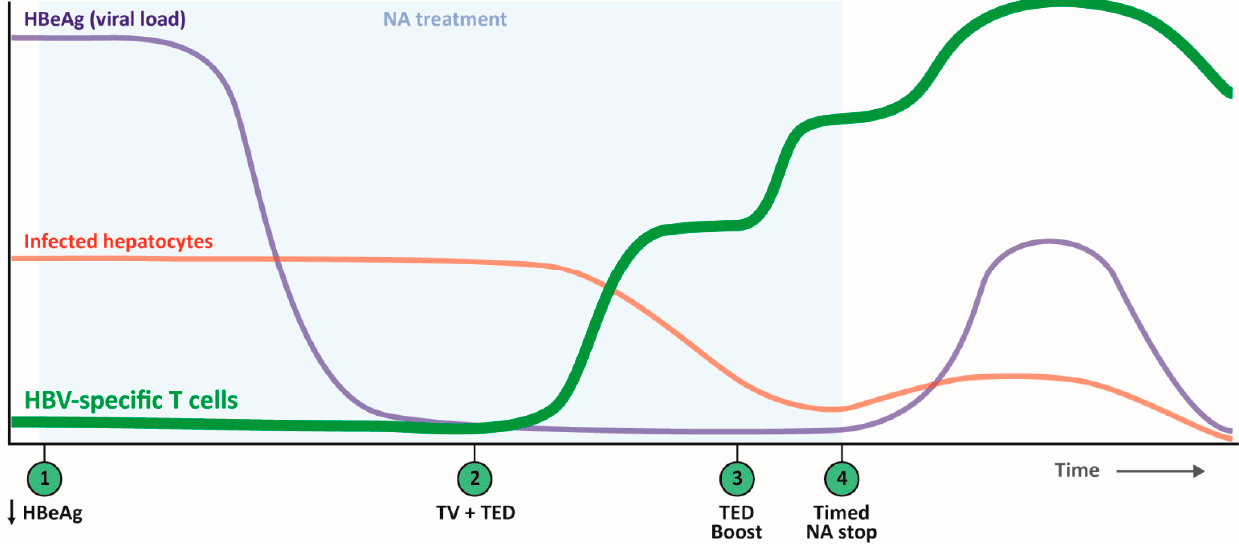
Figure 3. Proposed stepwise therapeutic strategy focused on opportunities to include CD4 + T cells. To induce multi-specific CD8 + and Th1 CD4 + T cells, first, HBeAg levels need to be reduced to remove the Th2 skewing environment by nucleos(t)ide analogue (NA) and/or siRNA treatment (step 1). When HBeAg/viral load are low, HBV-specific CD4 + and CD8 + T cells can be induced/boosted using therapeutic vaccines (TV) such as synthetic long peptide (SLP) or DNA/RNA vaccines including a Th1 skewing/IL-12 inducing adjuvant (step 2), which will result in a decrease in infected hepatocytes. TV can be combined with T cell enhancing drugs (TED) that are administered before, simultaneously or after TV depending on the type of TED (steps 2 and 3). Thereafter, when high T cell numbers of sufficient quality are obtained, a well-timed NA stop could serve as a natural booster by increasing viral load (step 4). This step-wise strategy may ultimately result in clearance of infected hepatocytes by the HBV-specific T cells and a functional cure.